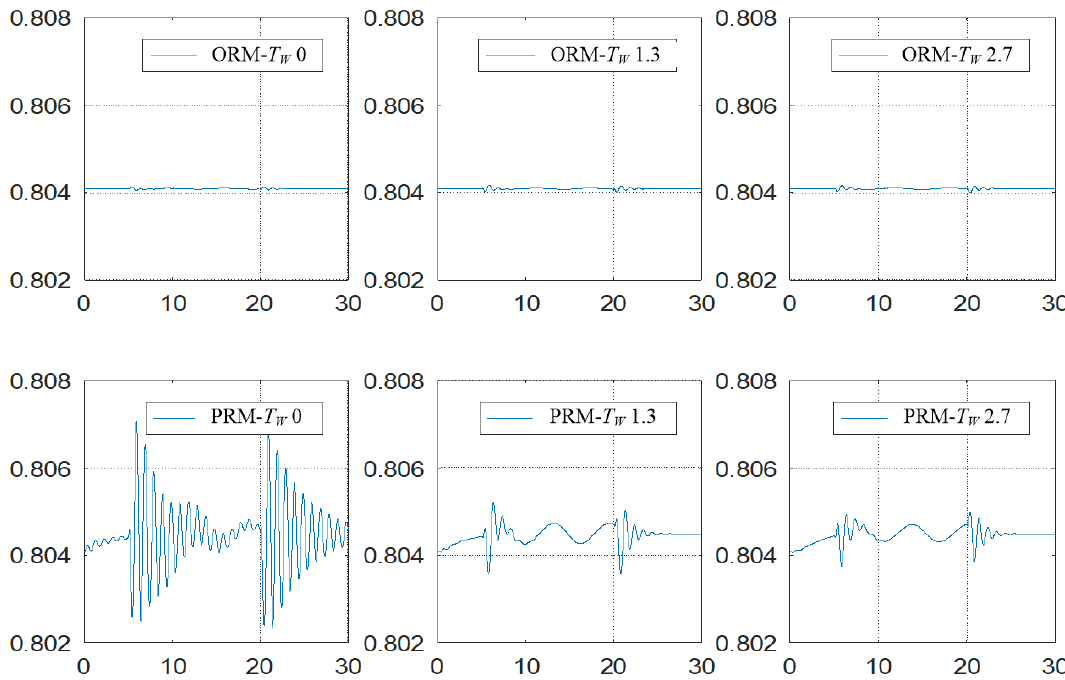
Figure 10. Response of rotor speed deviation x under a three-phase short circuit.